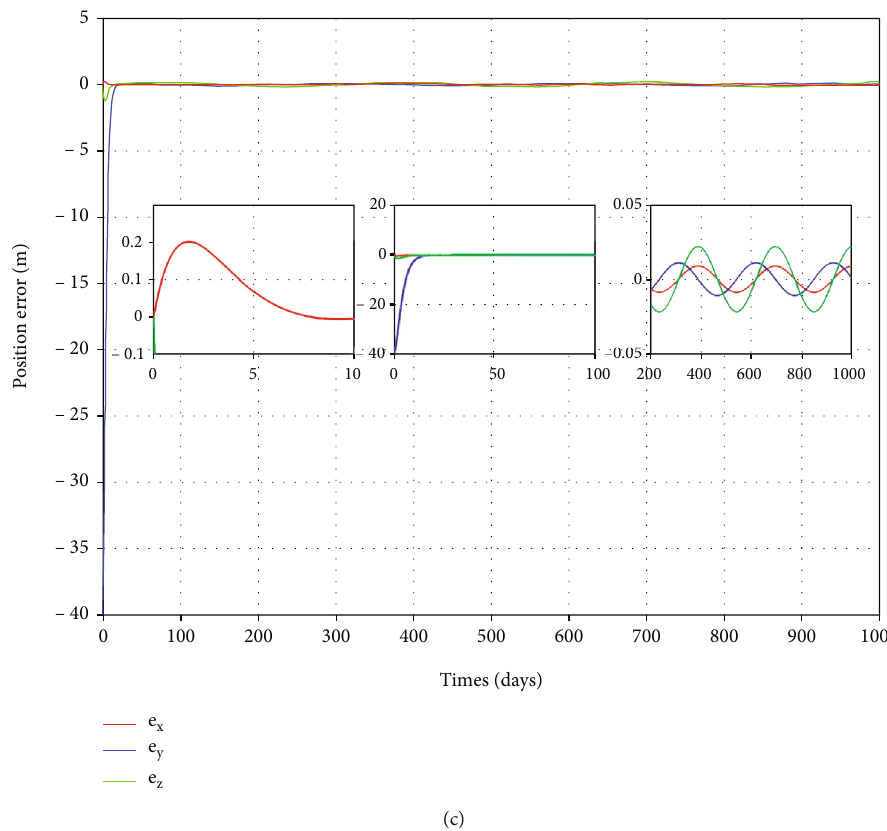
Figure 9: Components of the position error (Follower 1) ((a) PID; (b) FTSMC; and (c) MFITSMC).